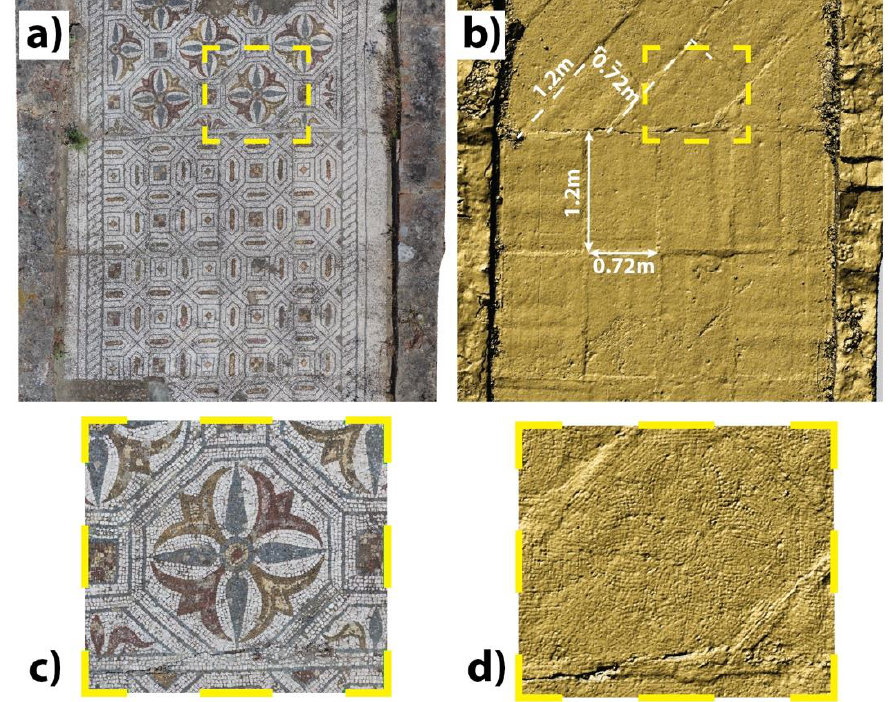
Figure 10. ( a ) Fragment of the obtained photogrammetric orthomosaic from the studied floor mosaic. ( b ) Fragment of the digital surface model (DSM) in the same area where the boundaries between the bedding mortar sections of different work planning units were perceived and measured. ( c ) Detail of the green detached square found in (a). ( d ) Detail of the green detached square found in (b).